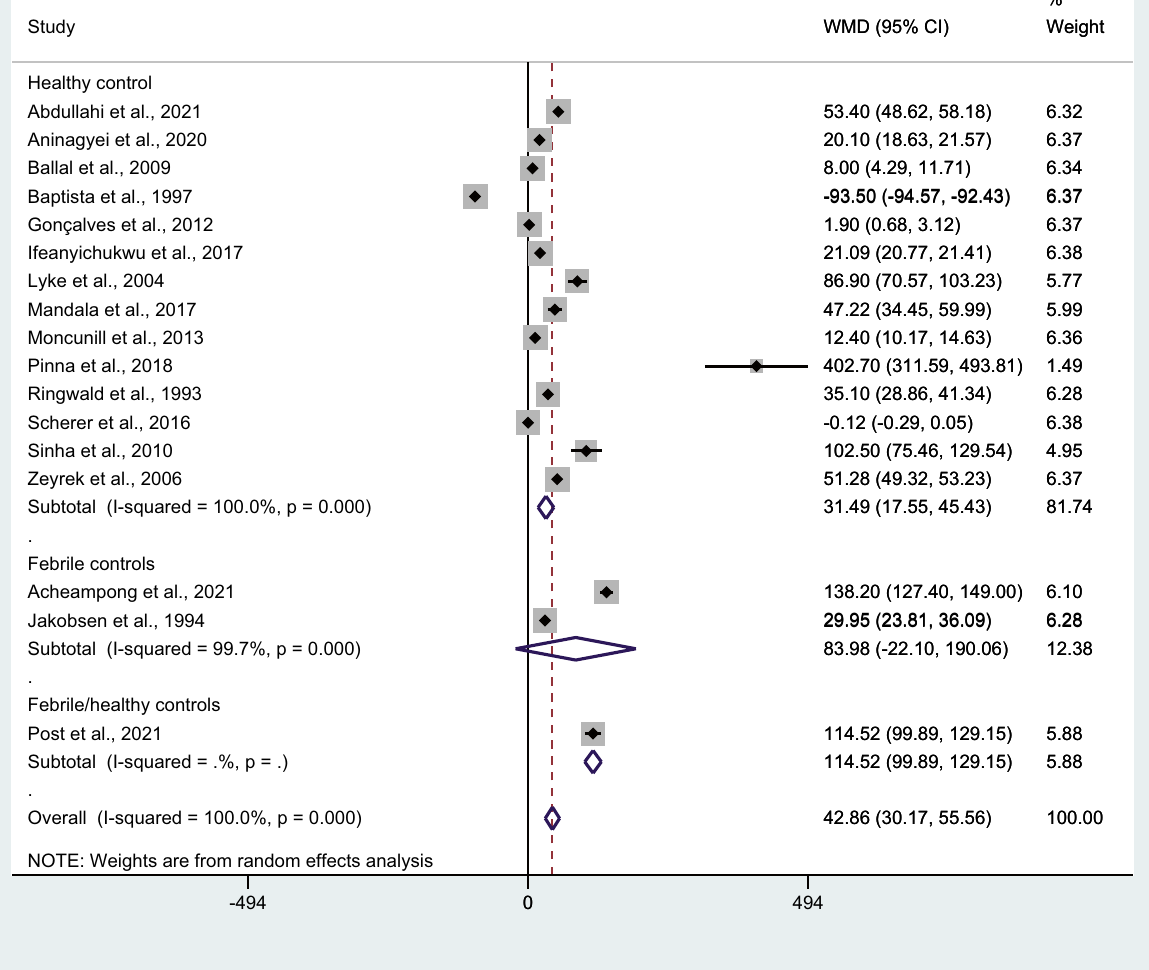
Figure 12. Differences in IL-6 levels between patients with uncomplicated malaria and controls by types of controls. Abbreviation: WMD, weighted mean difference; CI, confidence interval; black diamond symbol, point estimate; solid line in the middle of the graph at 0, zero effect size; Dashed red line: pooled WMD between the two groups; I 2 , level of heterogeneity; P = 0.000 or less than 0.05, significant